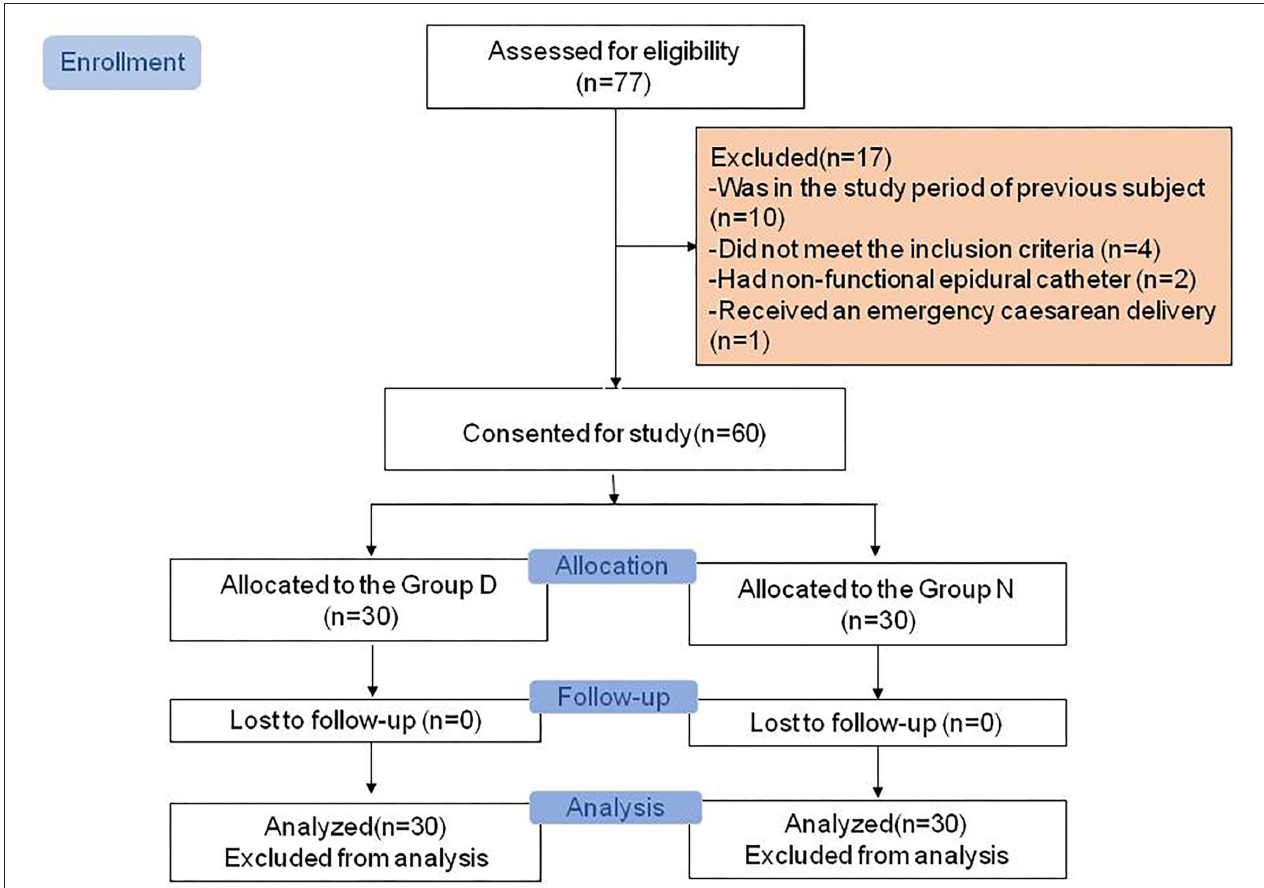
FIGURE 1 | Consolidated Standards of Reporting Trials (CONSORT) diagram showing patient recruitment and study flow.